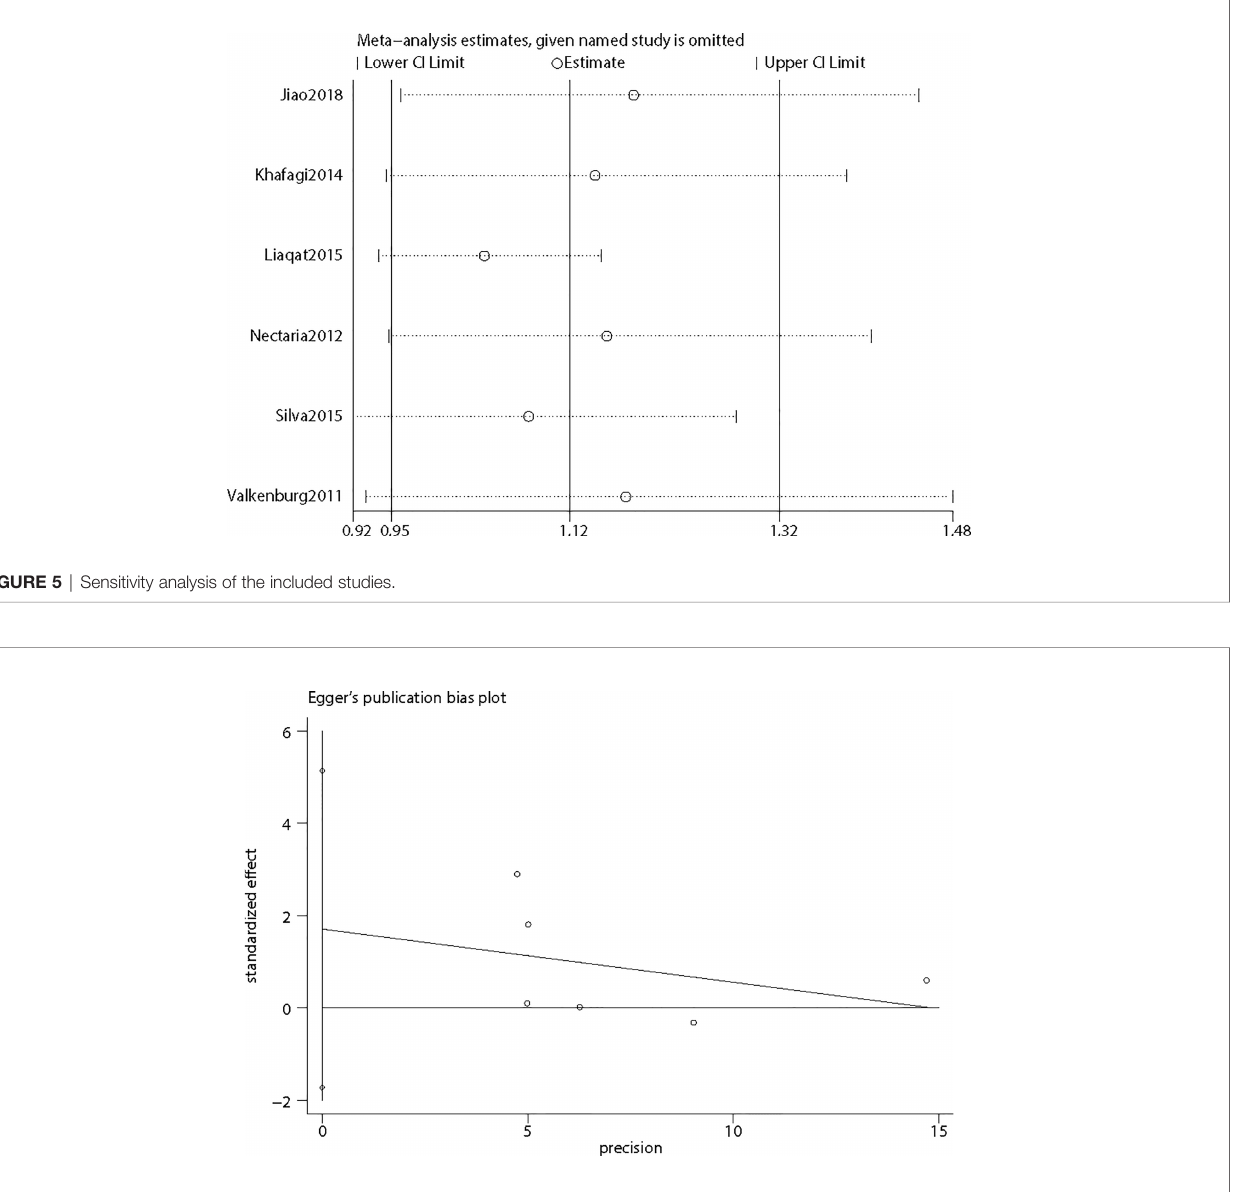
FIGURE 6 | Egger ’ s publication bias